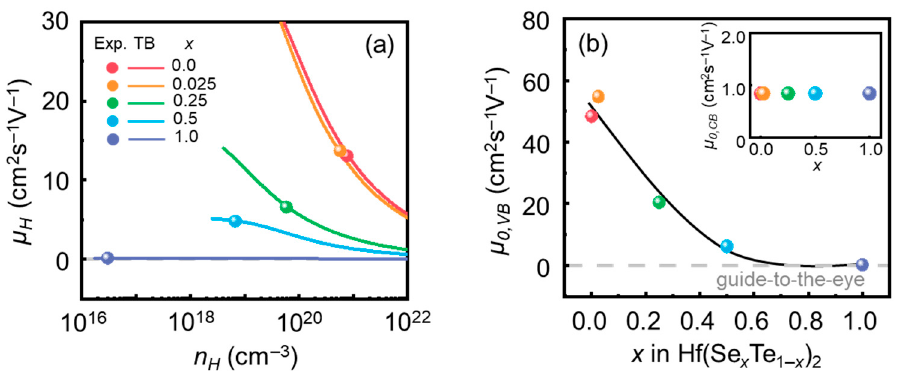
Figure 2. ( a ) Experimental (symbols) and theoretical (lines) μ H in terms of n H for Hf(Te 1 − x Se x ) 2 ( x = 0.0, 0.025, 0.25, 0.5, and 1.0) at 300 K [22], ( b ) estimated μ 0 , VB (= μ 0 for holes) in terms of Se alloying content ( x ) at 300 K. The x -dependent μ 0 , CB (= μ 0 for electrons) at 300 K is provided in the inset.